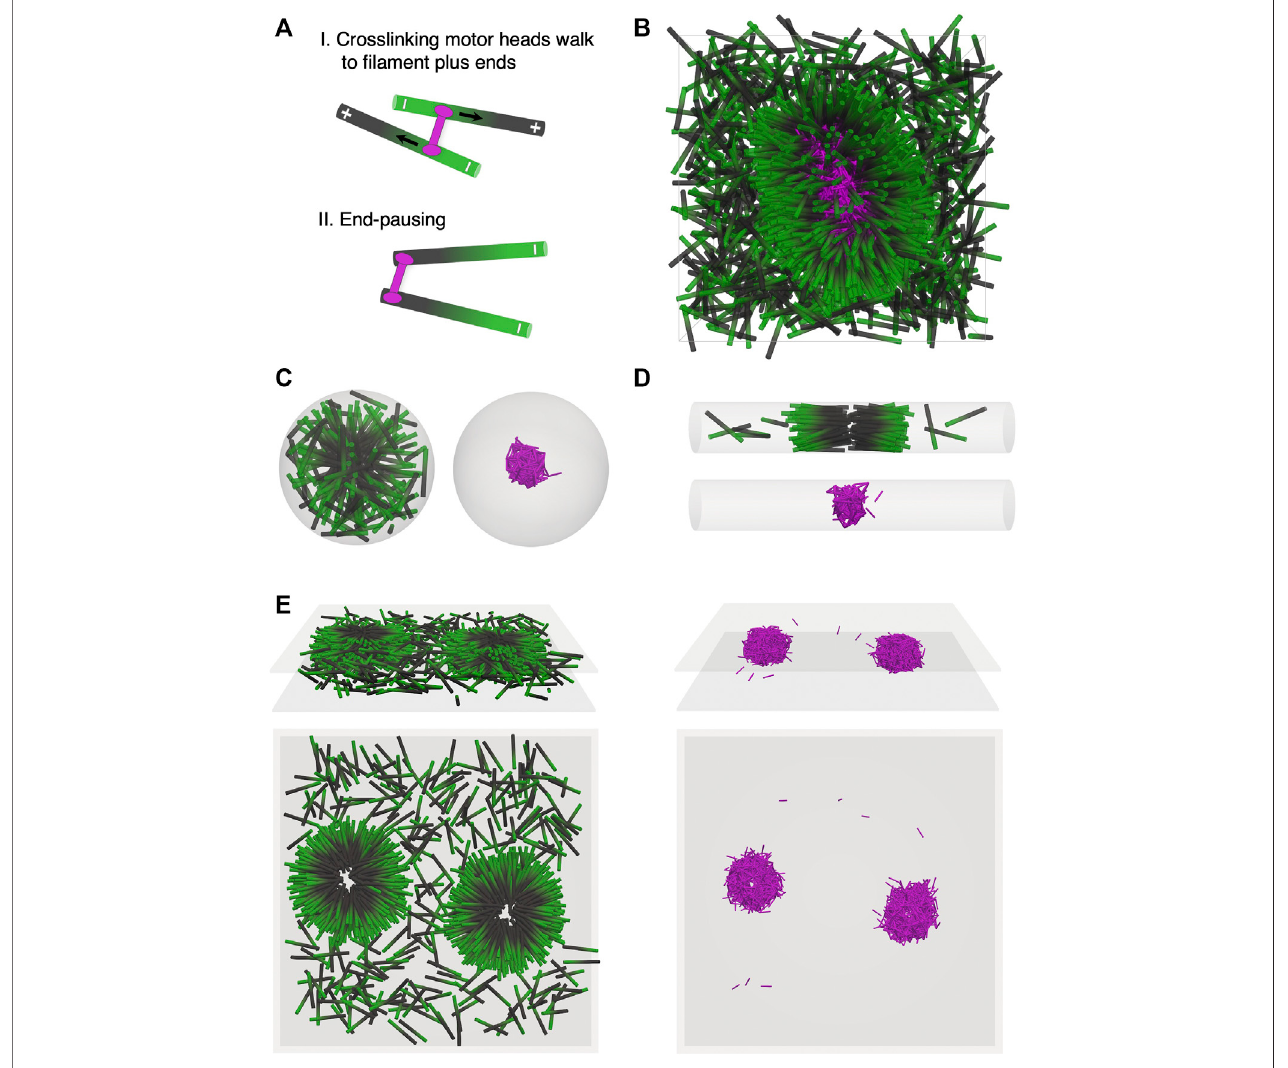
FIGURE1| Self-organizationof fi lamentsand crosslinkingmotor proteins isaffected bycon fi nement geometry. (A) End-pausing crosslinking motors (pink)bind to fi laments(minusendgreen,plusendblack) andeachmotorheadwalkstotheplusendofthe fi lamenttowhichitisbound.Uponreachingtheplusend,themotorheads stop walkingand pause there. (B – E) Simulationsnapshots ata fi lament packing fraction of ϕ =0.08.Thiscorrespondsto1,600 fi lamentsin B,D,E,and 181 fi laments in C. The number of crosslinking motors in each geometry is three times the number of fi laments. (B) Simulation snapshot of an uncon fi ned system of fi laments and crosslinking motors in a 3D periodic box. End pausing of crosslinking motor heads leads to tip accumulation of crosslinking motors on fi lament plus ends. (C) Spherical con fi nement. Filaments (left) self-organize into a symmetric 3D aster with the motors (right) forming a core near the center of the aster. (D) Cylindrical con fi nement. Filaments (top) form a polarity sorted bilayer oriented along the cylindrical axis. Motors (bottom) polarity sort the fi laments. (E) Planar con fi nement. Filaments (left) self- organize into fl attened asters due to activity of motors (right). Top (3D view) and bottom (top view).